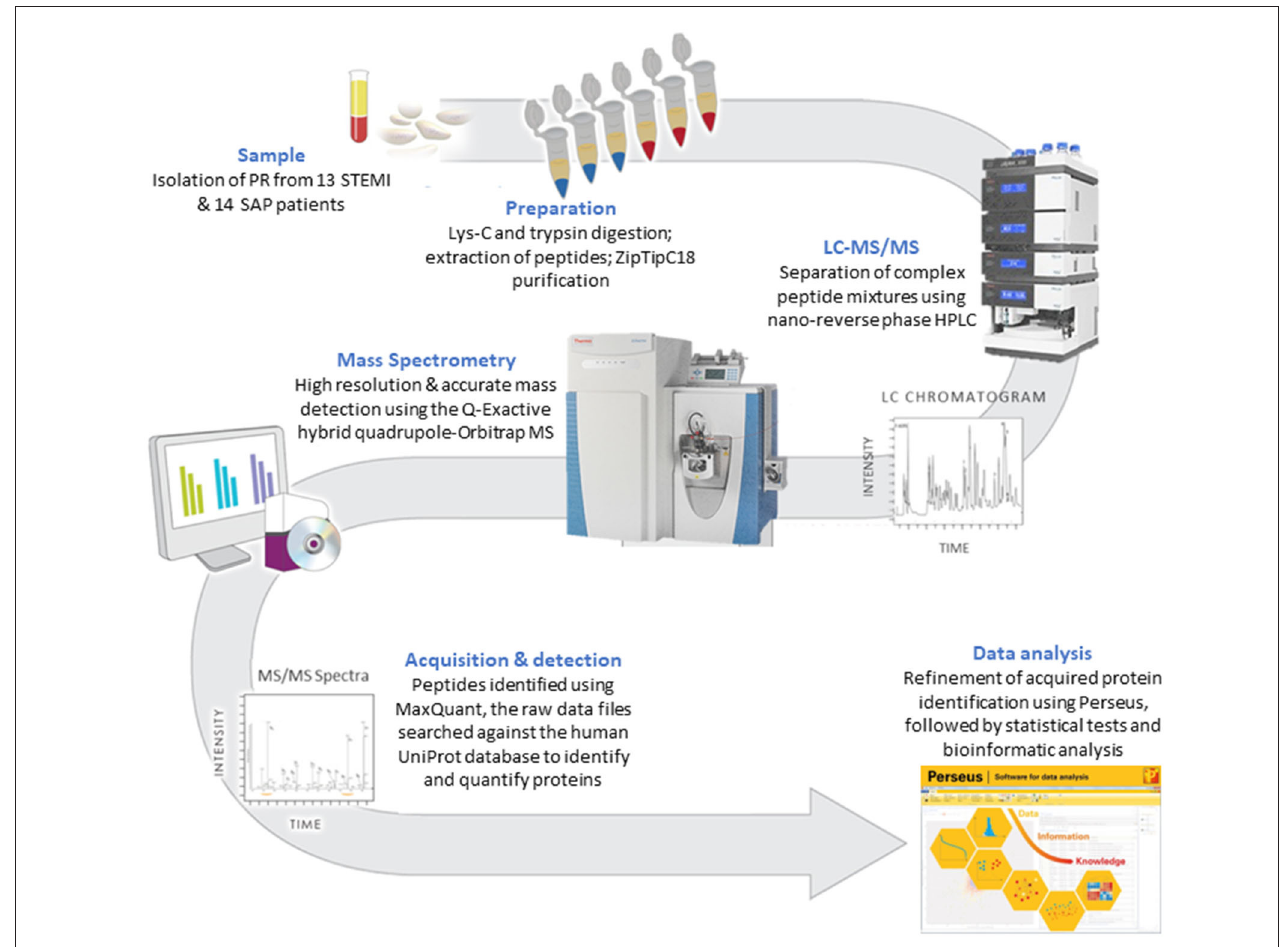
FIGURE 1 | A flow chart of the methodology used to compare the PR proteome in STEMI vs. SAP.